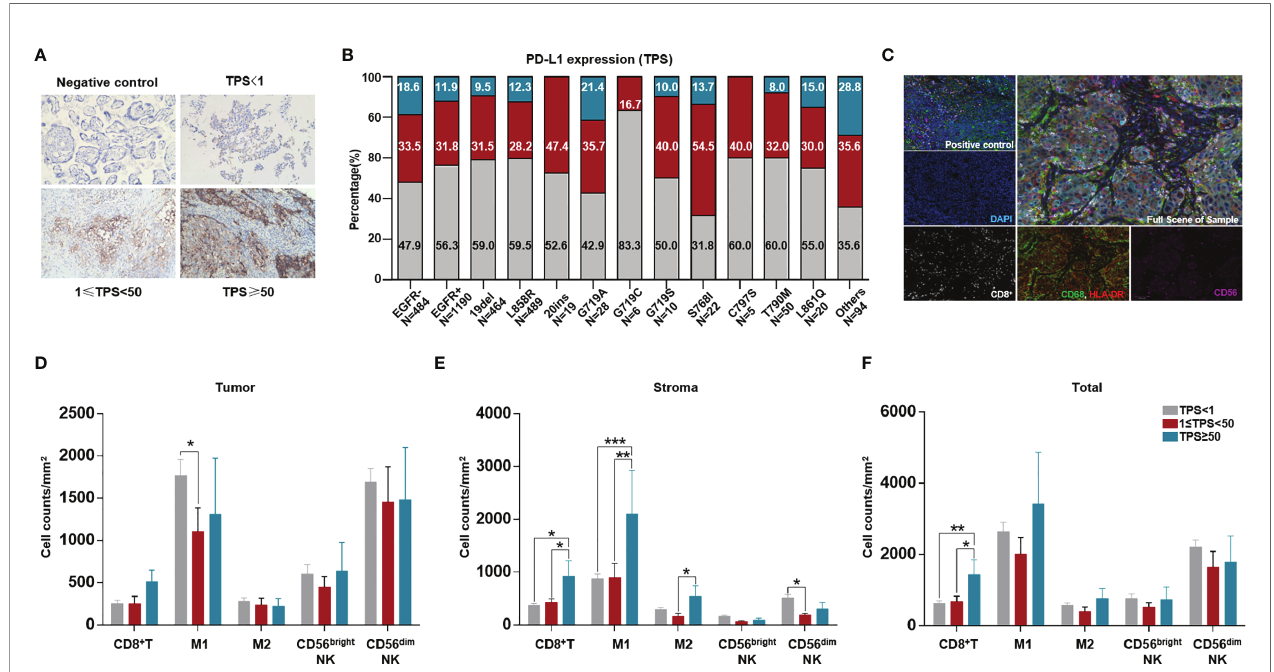
FIGURE 3 | Comparation of tumor PD-L1 expression and ratio among different EGFR mutation subtypes and difference of TIME among different TPS groups. PD-L1 expression was quanti fi ed as negative (TPS<1%), intermediate positive (1% ≤ TPS<49%), and strong positive (TPS ≥ 50%) for available cases and tabulated across different EGFR mutation subtypes. (A) Representative staining of PD-L1 expression through IHC (200X). (B) Comparation of PD-L1 expression between tumors with and without EGFR mutation, and among different EGFR mutation subtypes. (C) Ratio of patients with MSI-H in Chinese NSCLC. A total of 3876 were available for count the ratio of MSI-H. A total of 141 NSCLC patients were available for analysis of both PD-L1 expression and TIME. (D) Representative staining for CD8 + T cells, CD56 bright and CD56 dim NK cells, CD68 + HLA-DR + M1, CD68 + HLA-DR - M2 TAM. CD8 (white), CD56 (purple), CD68 (green), HLA-DR (red), panCK/S100(cyan), DAPI (blue). (E, F) different immune cell counts in intra-tumoral region, stroma, and sum of both. *means p < 0.05, **means p < 0.01, ***means p <